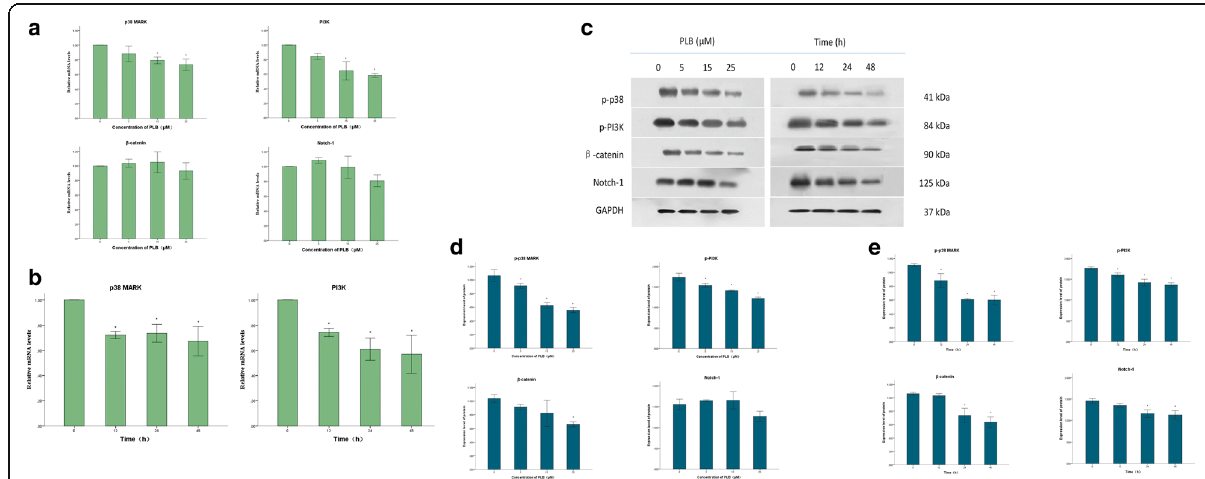
Fig. 5 Effect of plumbagin on the different signal pathways in ARPE cells. (*: P < 0.05 by one-way ANOVA, n = 3). Notes: ( a ) The relative mRNA expression levels of p38 MARK, PI3K, β -catenin and Notch-1 determined by QPCR when ARPE cells were treated with plumbagin at 0,5,15 and 25 μ M. β -actin was used as the internal control; ( b ) The relative mRNA expression levels of p38 MARK and PI3K determined by QPCR when ARPE cells were treated with plumbagin at 15 μ M for 0, 12, 24 and 48 h. β -actin was used as the internal control; ( c ) The protein levels of p-p38 MARK, p-PI3K, β -catenin and Notch-1 determined by Western blotting assay. GAPDH was used as the internal control; ( d ) The relative protein levels of p-p38 MARK, p-PI3K, β -catenin and Notch-1 when ARPE cells were treated with plumbagin at 0,5,15 and 25 μ M; ( e ) The relative protein levels of p-p38 MARK, p-PI3K, β -catenin and Notch-1 when ARPE cells were treated with plumbagin at 15 μ M for 0, 12, 24 and 48